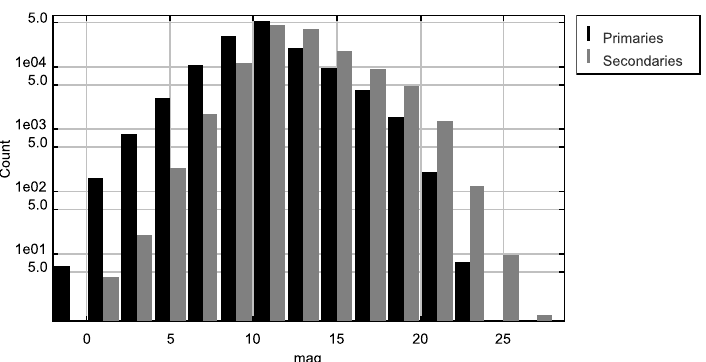
Fig. 4. The distribution of the primary ( m 1 , the black bars) and secondary ( m 2 , the gray bars) magnitudes of the listed systems.